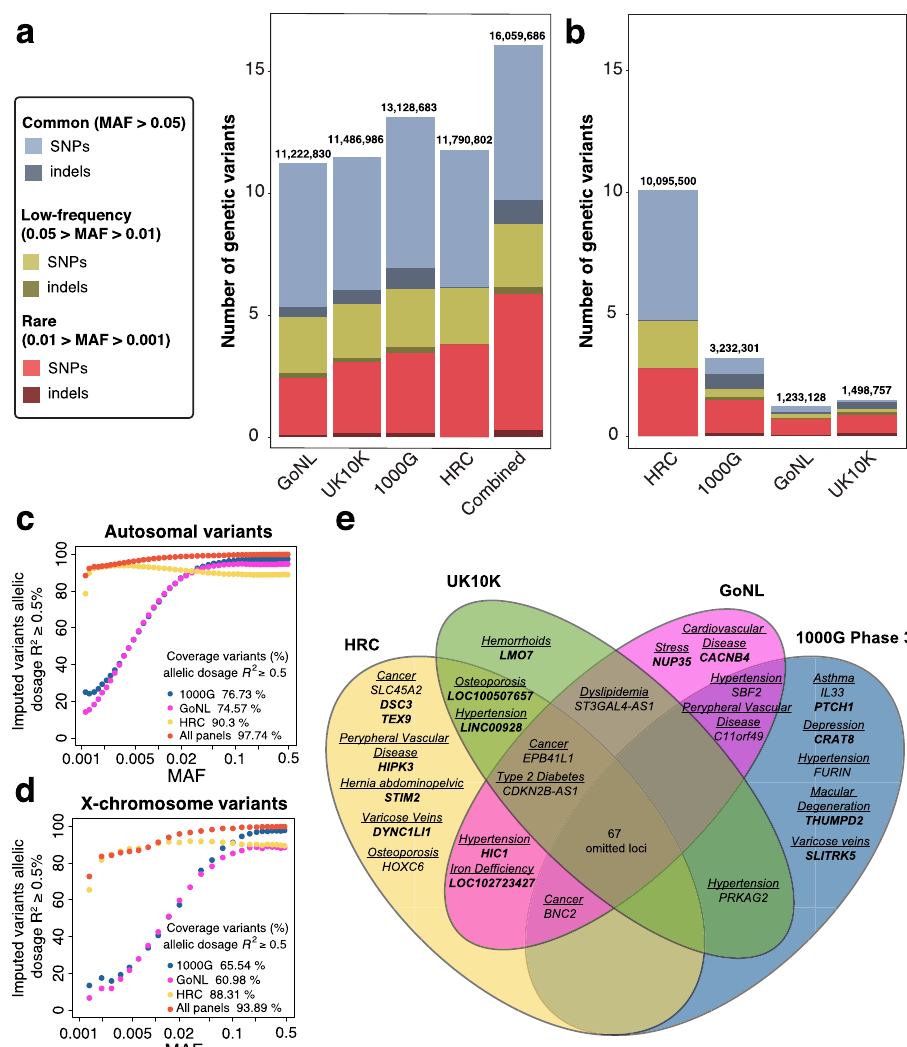
Fig. 1 Graphical representation illustrating the bene fi ts of combining the results from different reference panels. a Comparison of the number of variants after the imputation with four reference panels (info score ≥ 0.7), and combining them, colored according to MAF and variant type (SNP vs alternative forms of variation, such as indels). As shown in the bar plot, combining the results from the four reference panels increased the fi nal set of variants for association testing when compared with the results for each of the panels alone (GoNL, UK10K, 1000G Phase 3, or HRC), especially in the low and rare frequency spectrum. For example, we covered up to 5.5 M rare variants (0.01> MAF > 0.001) by combining panels, while only 2.3 M, 2.9 M, 3.2 M, and 3.8 M of rare variants were imputed independently with GoNL, UK10K, 1000G phase 3, and HRC, respectively. b Comparison of the contribution of each reference panel in the combined results. Each bar represents the number of variants that had the best imputation accuracy for a given reference panel. As shown in the fi gure, although the HRC panel showed overall higher imputation scores, as it provided around 10 of the fi nal 16 M variants, the contribution of the other reference panels, primarily with non-SNP variants, was substantial. Indels seen in the bar plot for HRC correspond to genotyped indels. All variants with info score <0.7, MAF < 0.001, and HWE for controls p < 1.0 × 10 − 6 were fi ltered. c Percentage of high-quality imputed variants (IMPUTE2-info score ≥ 0.7) with an allelic dosage R 2 ≥ 0.5 between sequenced genotypes in UK10K samples vs variants imputed in the same UK10K samples using 1000G phase 3, GoNL, and HRC reference panels for the autosomes. The percentage of high-quality imputed variants with allelic dosage R 2 values ( y axis) are represented across several MAF ranges ( x -axis) for each of the reference panels and the combined panels imputed results. The combination of the three reference panels outperforms the single reference panels with 97.74% of variants with R 2 ≥ 0.5. d Percentage of variants in the X chromosome with an IMPUTE2-info score ≥ 0.7 and with an allelic dosage R 2 ≥ 0.5 for UK10K imputed genotypes across MAF ranges for 1000G phase 3, GoNL, and HRC reference panels and the combined results. The combination of the results from the three panels outperforms single reference panels with 93.89% of variants with allelic dosage R 2 ≥ 0.5. e Venn Diagram illustrating the loci identi fi ed by each reference panel. New loci are depicted in bold. As shown in this fi gure, only 67 of the 94 GWAS signi fi cant loci were identi fi ed by all four reference panels, while 27 of them (28.7%) were only identi fi ed by one, two, or three of the four